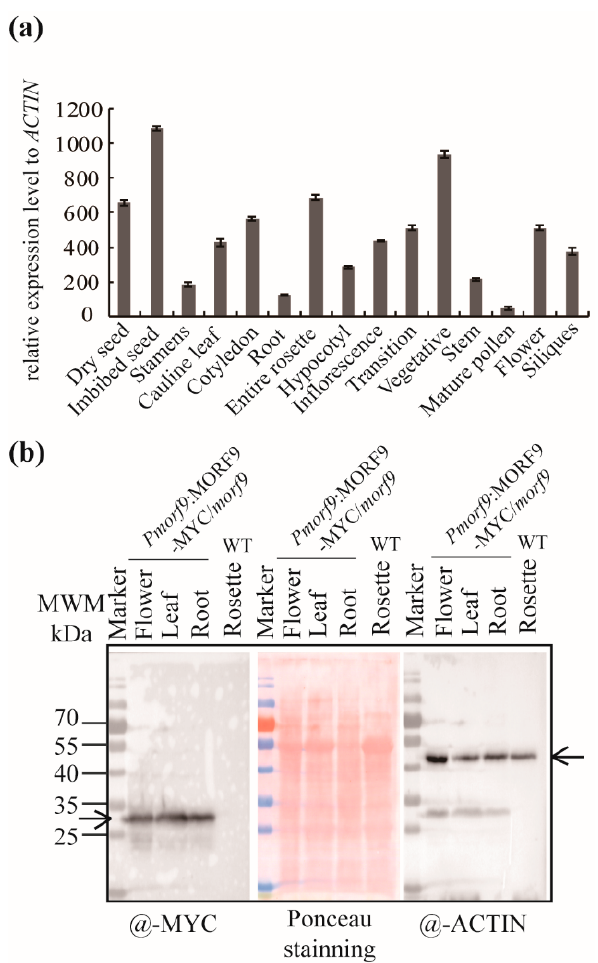
Figure 4. MORF9 transcript and protein levels in various tissues and organs. ( a ) The transcript levels of MORF9 in various tissues and organs retrieved from public datasets [33]; ( b ) Protein levels of MORF9 in various organs in Pmorf9:MORF9-myc plants, determined by using an antibody against MYC. The same membrane was subsequently probed with an anti-ACTIN antibody for loading control. Ponceau staining prior to immunodetection shows total proteins on the membrane. Arrows indicate the expected bands.